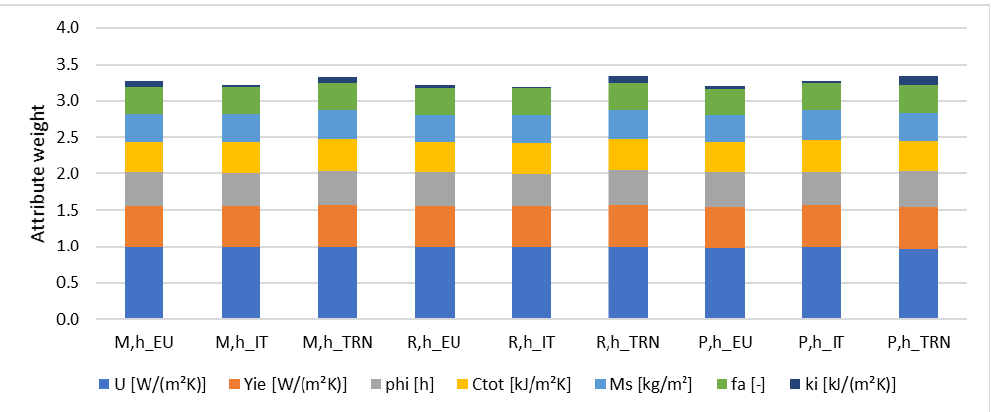
Figure 13. Weight analysis of the thermo-physical attributes of opaque structures, for the winter period and with g gl,n = 0.34.